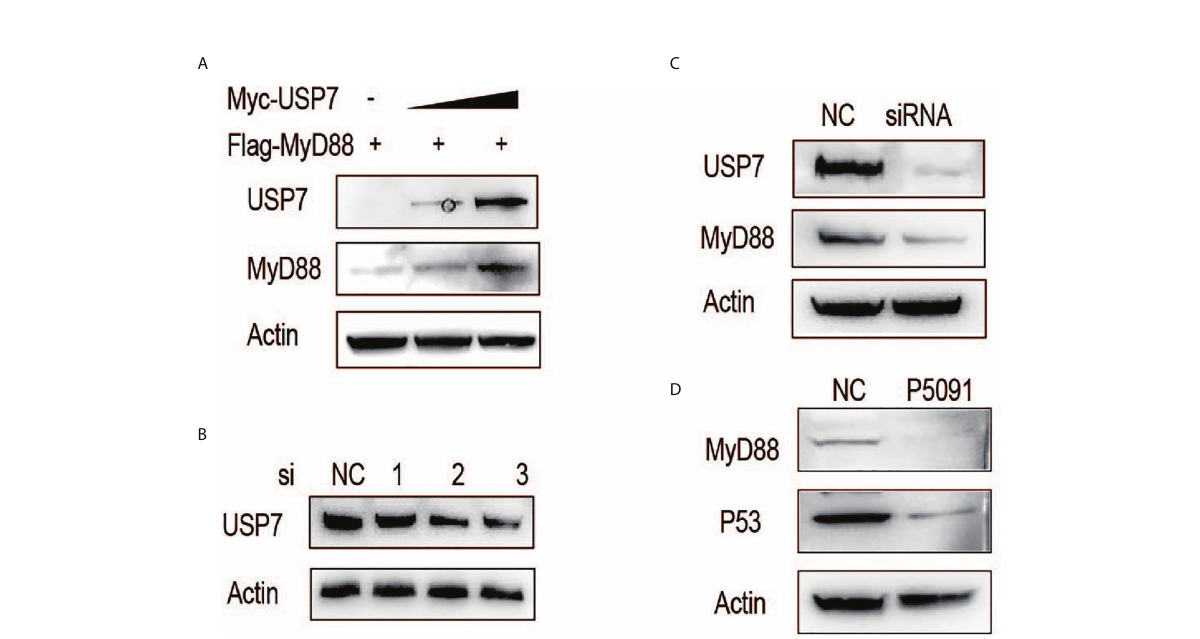
FIGURE 1 ChUSP7 promotes protein stability of chMyD88. (A) Chicken DF1 cells were transfected with increasing doses of Myc-tagged chUSP7, and expression of the indicated proteins was analyzed by immunoblot. (B) Knockdown ef fi ciency of different siRNAs designed to target chUSP7. The protein levels of chUSP7 were examined by western blot. (C) Immunoblot analysis of endogenous chMyD88 in cells transfected with siRNA against chUSP7. (D) Immunoblot analysis of MyD88 in P5091 treated CHO cells. P53 was a previously identi fi ed target inhibited by P5091 to show the effect of